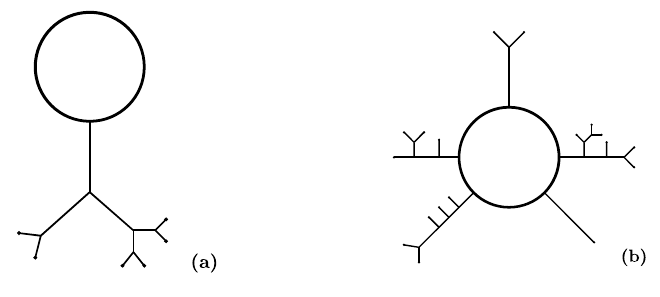
Figure 2 . (a) A particular OPE channel for 6-point torus block. (b) Arbitrary torus channel Ch .